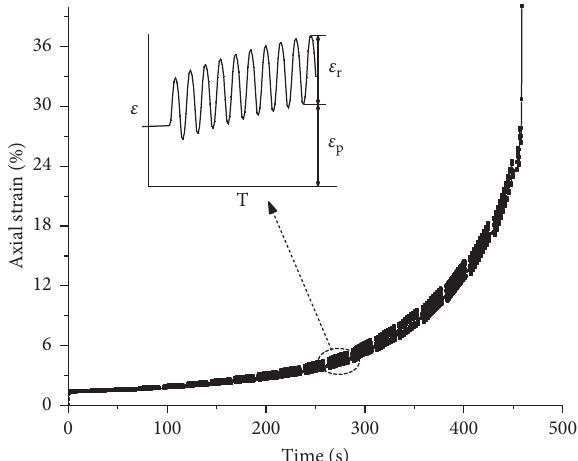
Figure 4: Time history curves of axial strain at 0.5 Hz.